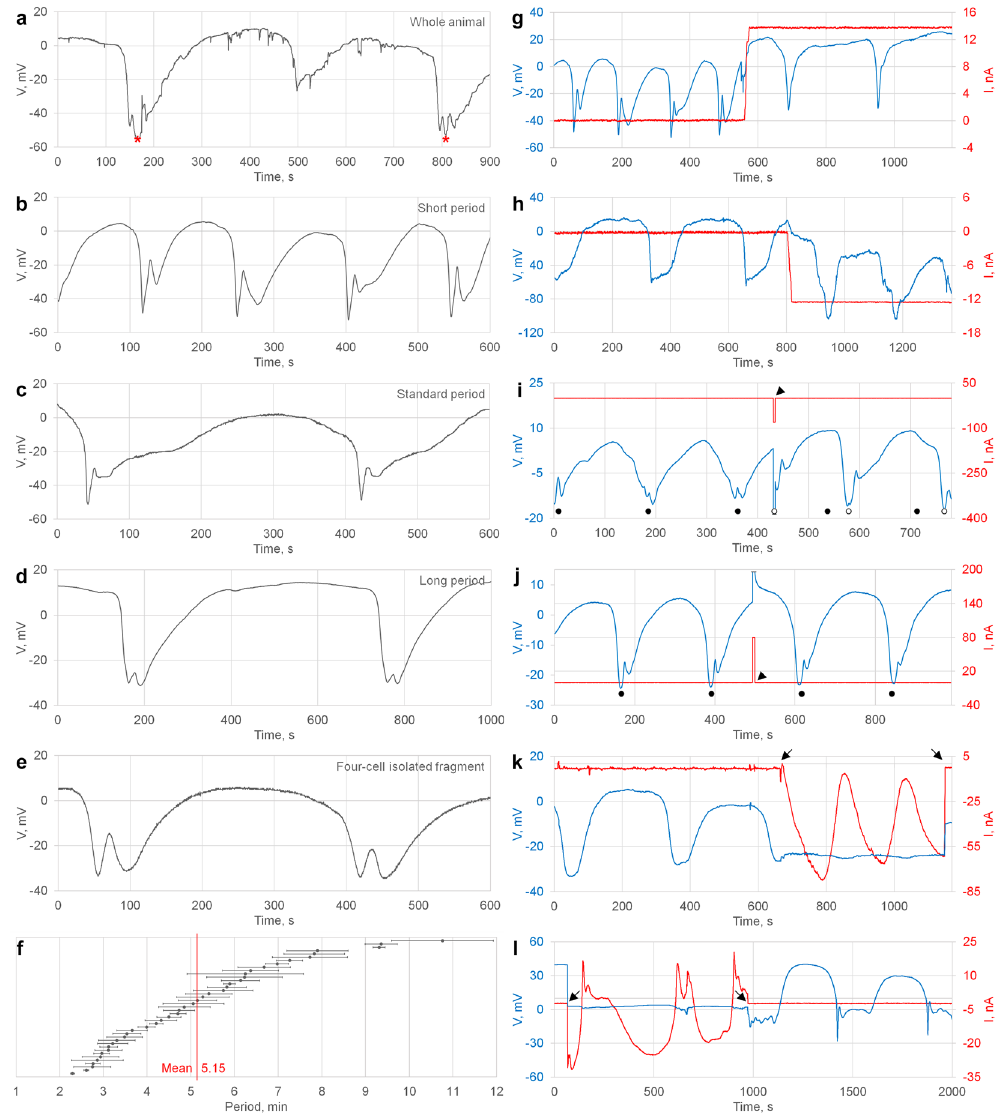
Figure 2. Rhythmical electrical activity in H . megidis nematode gut. ( a ) Intracellular recordings of the spontaneous voltage oscillations in a whole animal (asterisks indicate defecation expulsions) and ( b , c , d , e ) isolated gut preparations. Examples of ( b ) short, ( c ) medium and ( d ) long cycle periods. ( e ) Small (four-cell) isolated gut fragment. ( f ) DMP period variability expressed as mean (SD) for 41 experiments with minimum four DMP cycles recorded, ranked according to mean period length. ( g , h , i , j , k , l ) Intracellular two-electrode recordings (voltage – blue, current – red). ( g ) Continuous depolarization via current electrode injection increases the DMP period and ( h ) continuous hyperpolarization decreases the period. i Short hyperpolarizing current pulse (arrowheads) resets DMP rhythm while j depolarizing current pulse produces no effect. Black dots mark initial DMP period. White dots mark phase after reset. Effects shown in ( g , h , i , j ) were reproduced for at least three times. ( k , l ) Current cycling in two experiments with different voltage clamp levels ( − 25 mV and 0 mV). Arrows show on and off voltage fixation